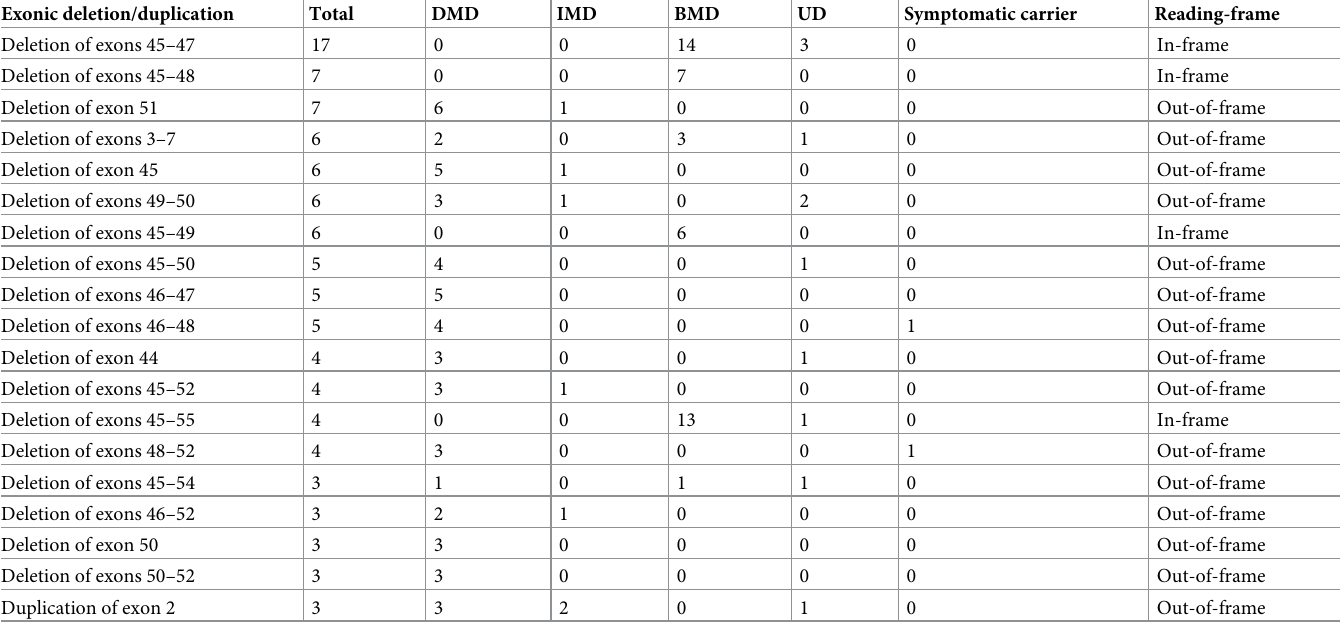
Table 2. Relationship between common exonic deletion/duplication and clinical phenotypes in Korean patients with